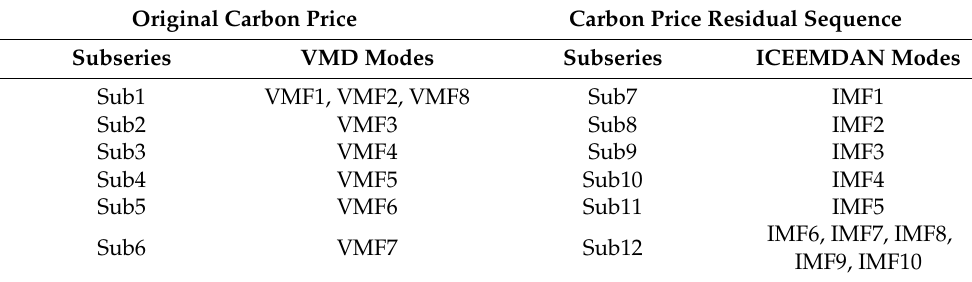
Table 3. Results of the reconstruction of the carbon price.